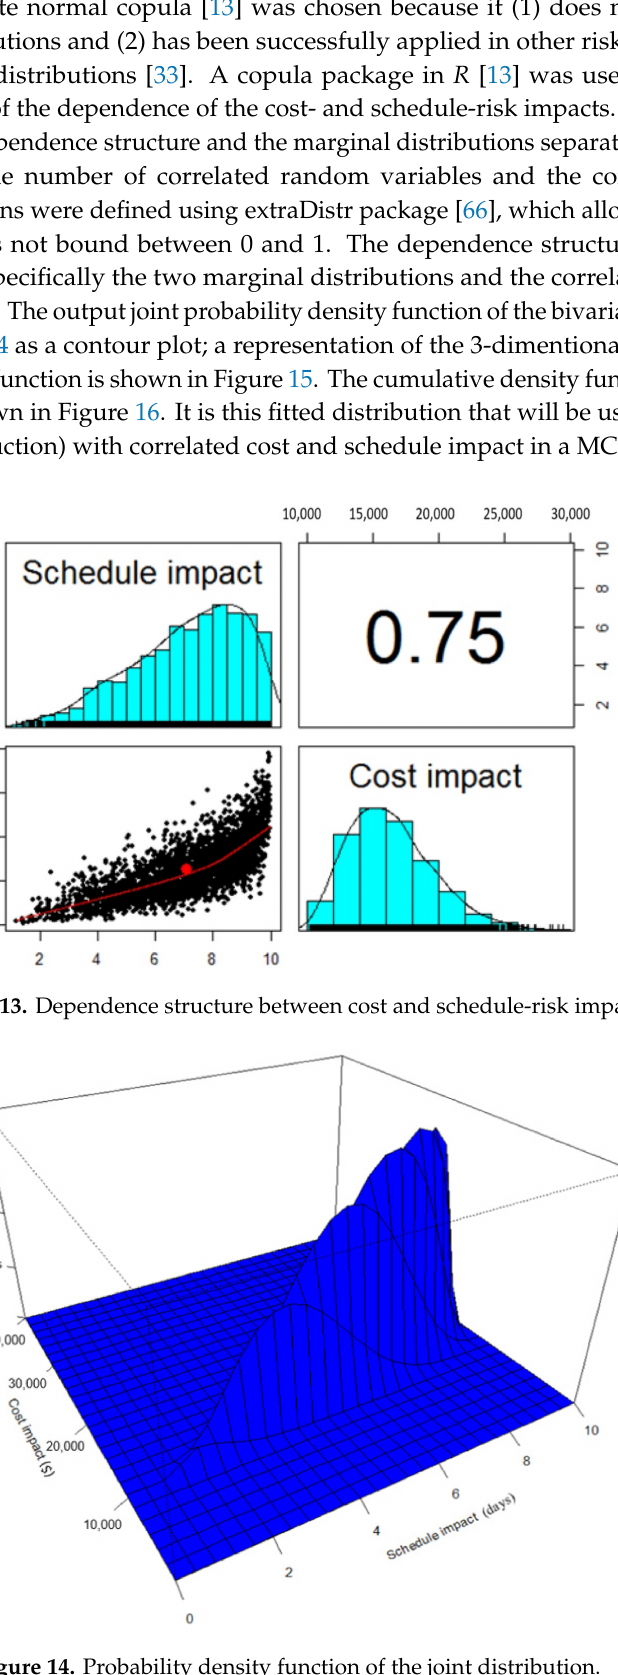
Figure 14. Probability density function of the joint